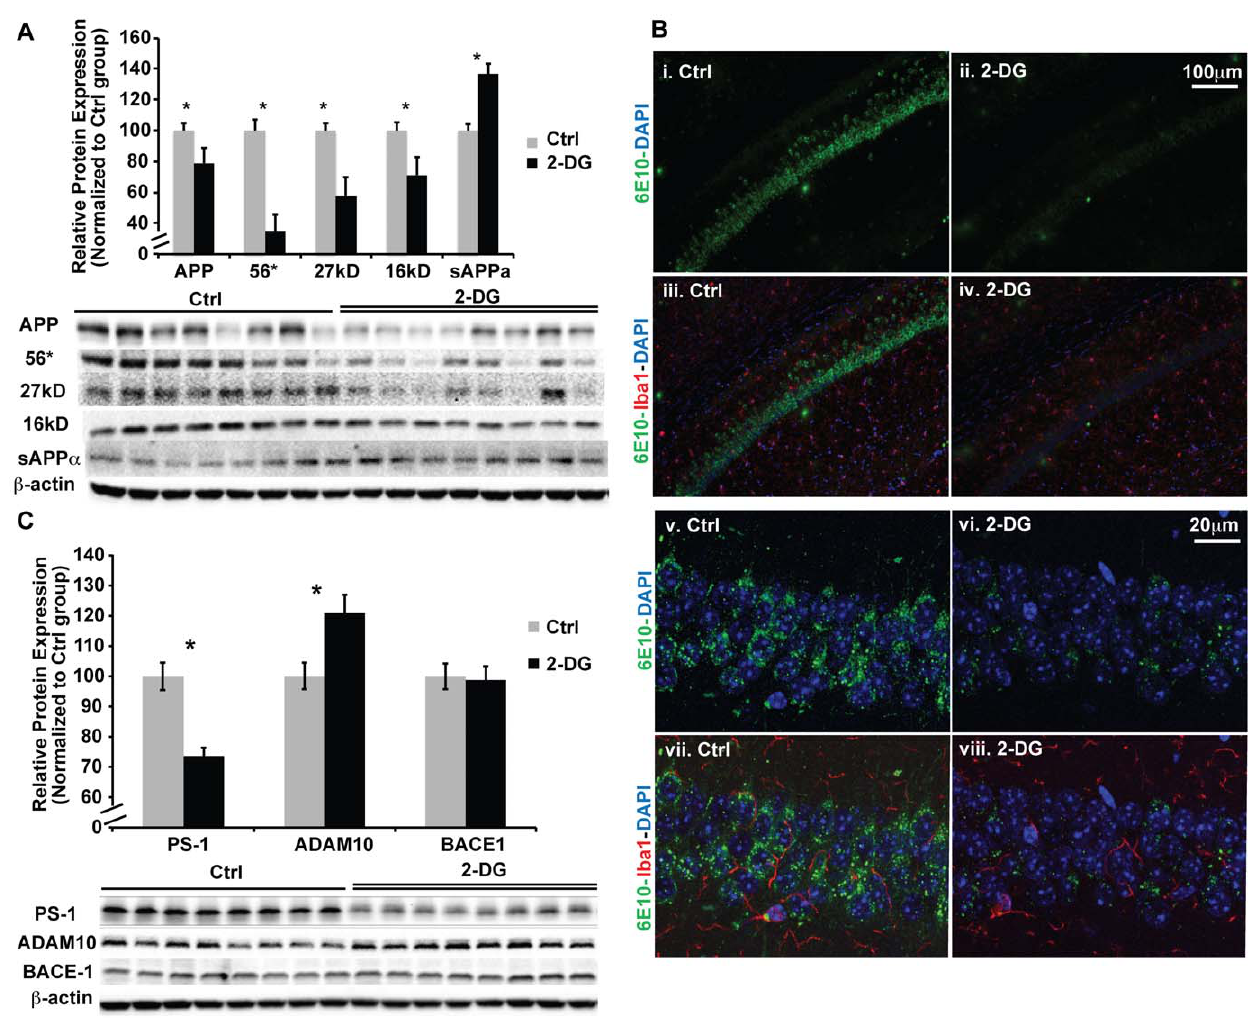
Figure 4. 2-DG reduced amyloid pathology through activation of the non-amyloidogenic pathway in 3xTgAD mice. Hippocampal homogenate samples from both the Ctrl and 2-DG groups were analyzed for protein levels of APP, multiple forms of A b oligomer (56 kD, 27 kD, 16 kD), sAPP a fragment, ADAM10, BACE1, and PS-1 by western blot. Brain sections were stained for amyloid species (6E10) and microglia marker (Iba I). A, 2-DG induced significant decrease in APP, 56 kD, 27 kD and 16 kD A b oligomer protein level. In contrast, sAPP a level was significantly increased by 2-DG (*, P , 0.05 compared to Ctrl, bars represent mean values 6 SEM); B, immunofluorescent labeling of amyloid with 6E10 antibody in the hippocampal CA1 region. Image i–iv: lower magnification, scale bar: 100 m m; images v–viii, higher magnification, scale bar: 20 m m. Images i, ii, v, and vi: 6E10 only, Images iii, iv, vii, and viii: 6E10 with microglia marker IbaI labeling and DAPI; C, 2-DG treatment significantly increased expression of a secretase ADAM10 protein levels. In contrast, c secretase PS-1 protein level was significantly decreased by 2-DG. b secretase was not changed by 2-DG (*, P , 0.05 compared to Ctrl, bars represent mean value 6 SEM).